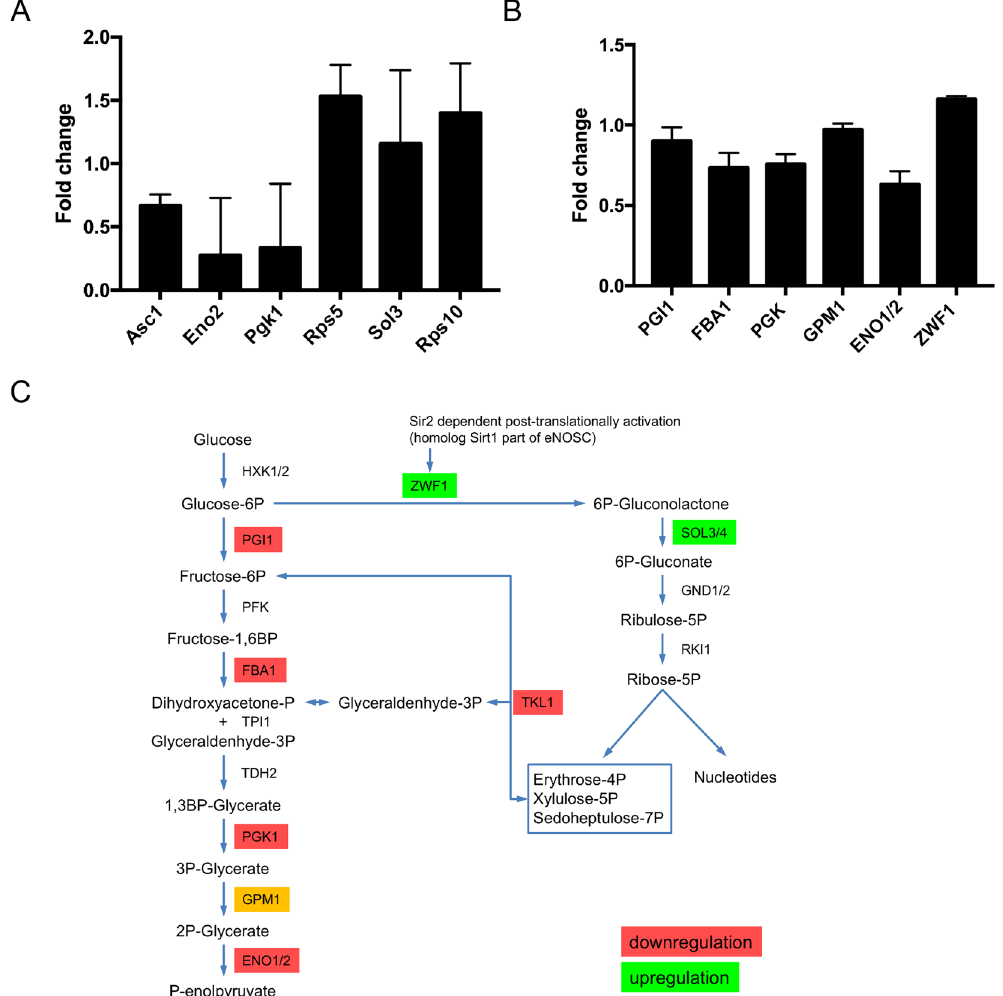
Figure 7. Quantitative PCR and biochemical activities of differentially regulated proteins in Δ rrp8 . ( A ) RTqPCR analysis of mRNAs from proteins that were differentially regulated in the rrp8 mutant strain are represented as fold change in mRNA expression. Expression of Asc1, Rps5, Eno2 and Pgk1 is regulated at the transcriptional level, whereas mRNA levels of Sol3 and Rps10A are not different from their wild-type level of expression. Data analyzed with the software REST ® .41. ( B ) Regulation of specific activities of enzymes of the carbohydrate metabolism within Δ rrp8 . Changes in the specific enzyme activities of phosphoglucose isomerase (PGI1), fructose-1,6-bisphosphate aldolase (FBA1), phosphoglycerate kinase (PGK1), phosphoglycerate mutase (GPM1), enolase (ENO1/ENO2) and glucose-6-phosphate dehydrogenase (ZWF1) are represented as fold change. Activities of enzymes involved in the glycolytic pathway are downregulated due to deletion of RRP8 as compared to wild-type. Only activity of ZFW1, first enzyme of the pentose-phosphate pathway, is slightly upregulated. ( C ) Schematic overview of regulations in the carbohydrate metabolism in cells with inactive